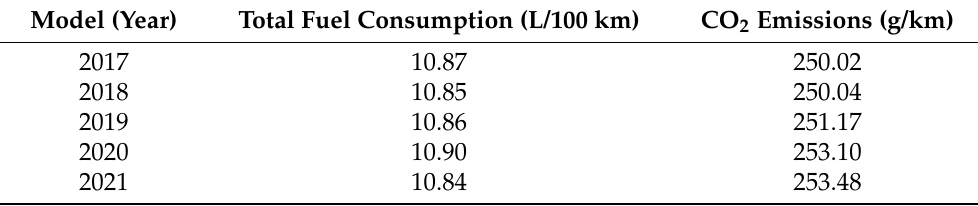
Table 9. CO 2 emissions (g/km) and total fuel consumption (L/100 km) over time. Model